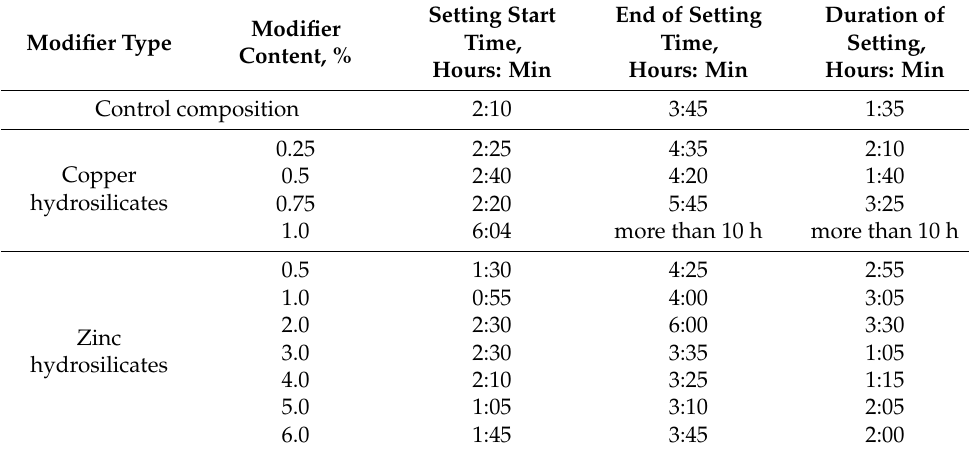
Table 3. Setting time of composite cement